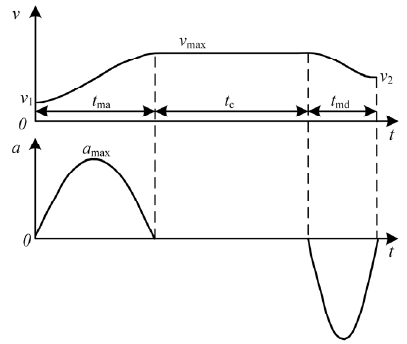
Figure 9. The velocity and acceleration curves.